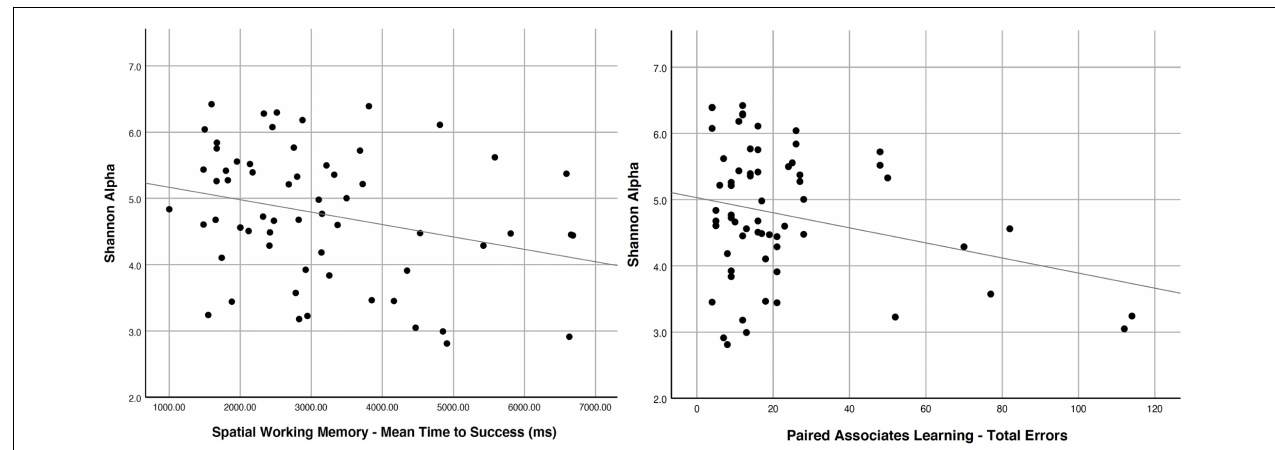
FIGURE 2 | Cognitive scores (CANTAB) related to the gut microbiome diversity score Shannon Alpha [Multivariate Model F (2,56) = 4.846, R 2 = 0.117] on spatial working memory ( left –longer times to success relate to lower diversity; p = 0.025) and paired associates learning ( right -higher errors on the task relate to lower diversity; p = 0.024). Reprinted from Canipe et al.